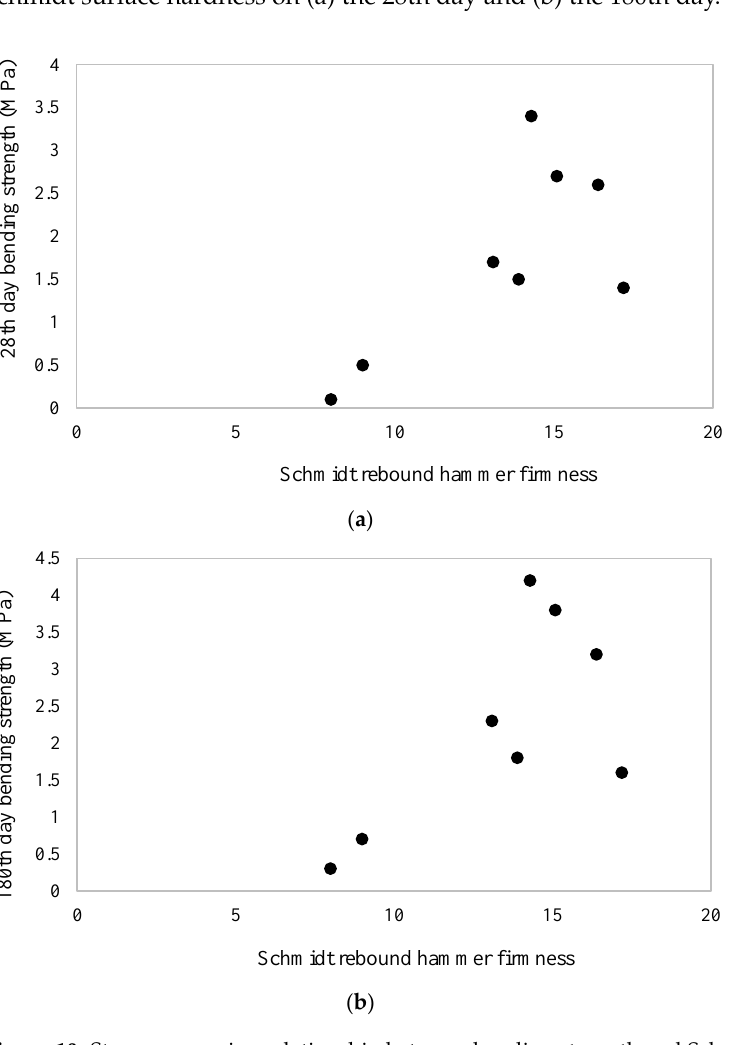
Table 8. Calibration equations for predicting bending strength from Schmidt surface hardness.